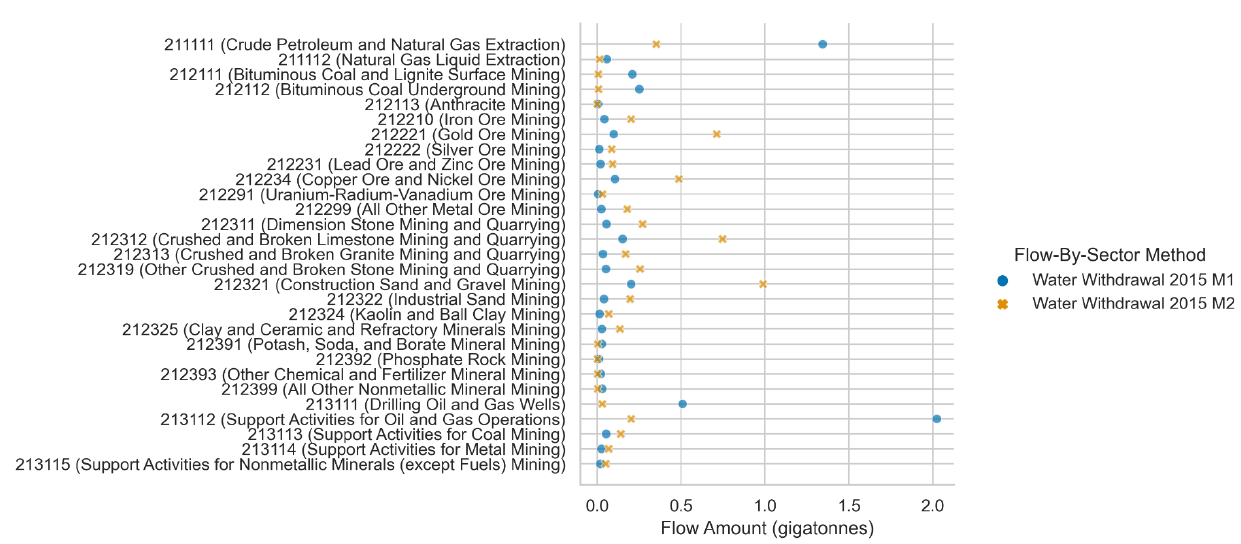
Figure 4. Comparing direct water withdrawals by 6-digit NAICS in 2015. Method 1 and Method 2 results were generated using the FBS methods “Water_national_2015_m1” and “Water_national_2015_m2,” respectively, with FLOWSA v1.2.1.